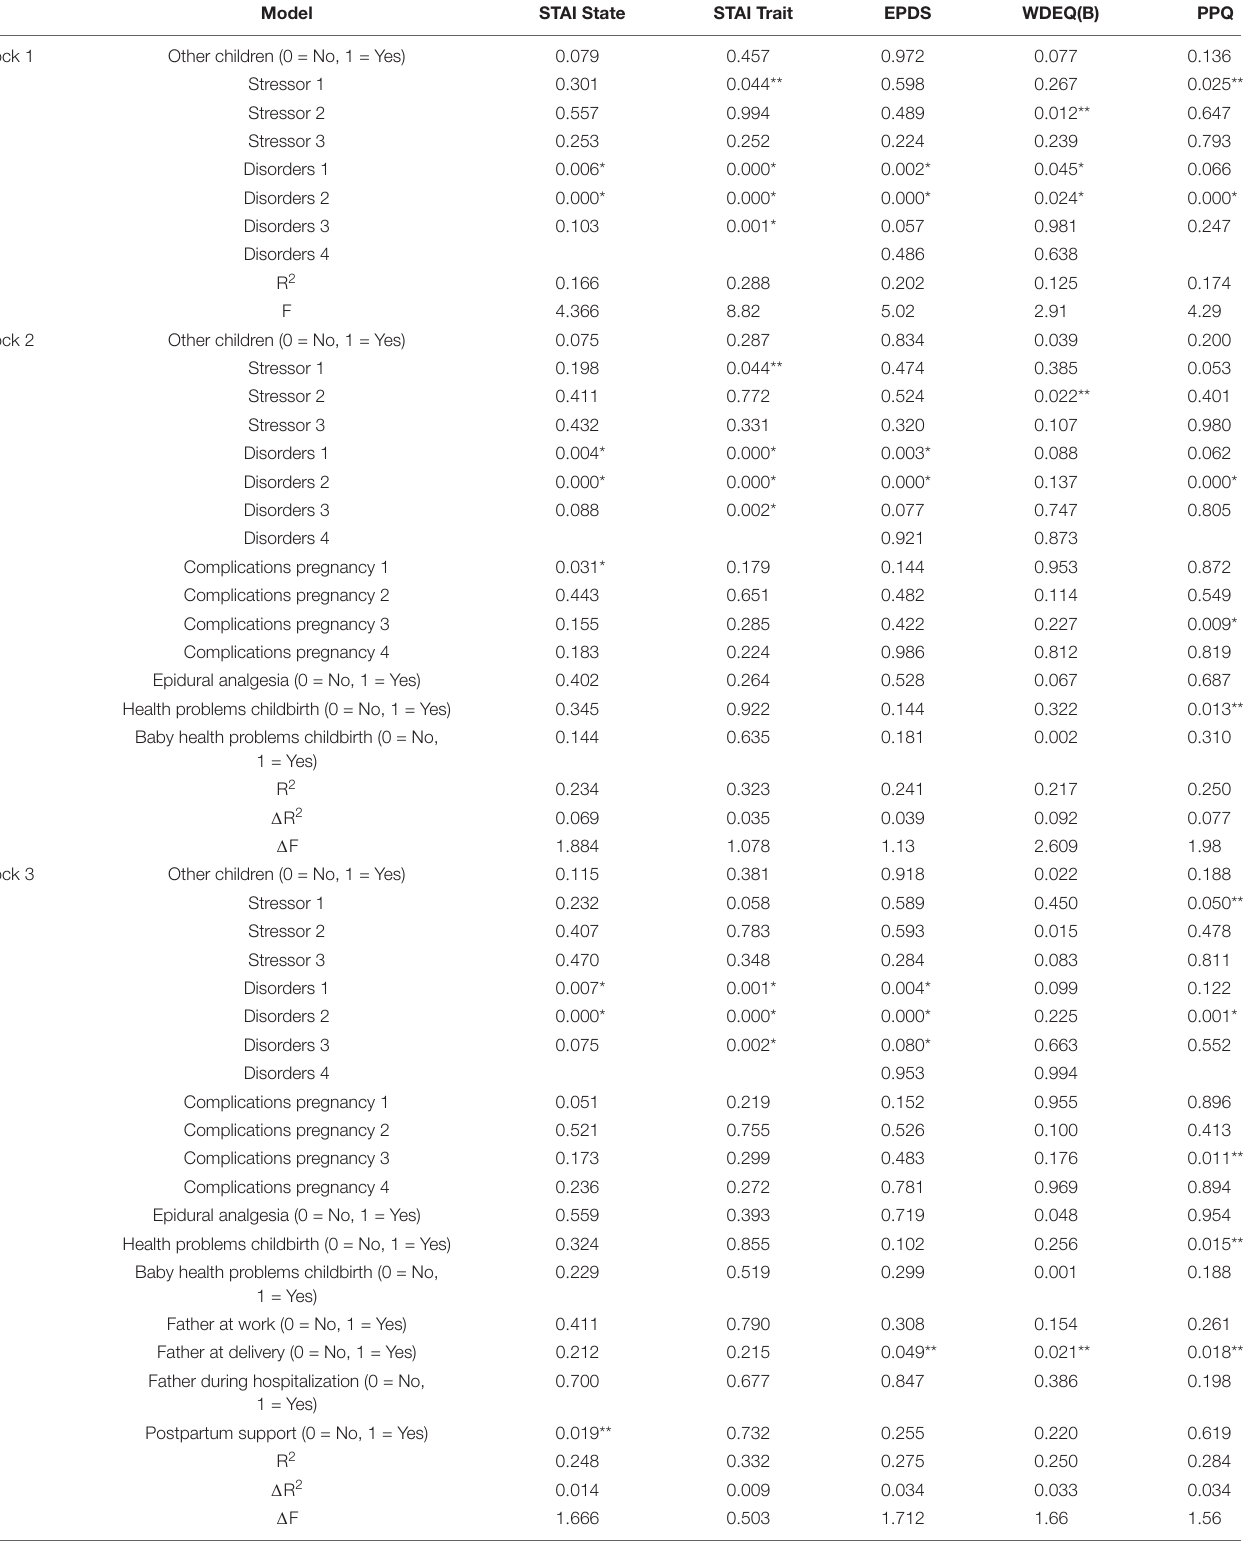
TABLE 3 | Postpartum women–Hierarchical Regression Analyses for STAI State, STAI Trait, EPDS, WDEQ(B), and PPQ. Model STAI State STAI Trait EPDS WDEQ(B)